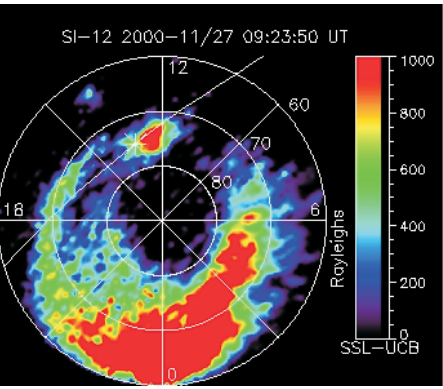
Fig. 9. IMAGE Lyman- α spectrograph data at 09:23:50 UT plotted in magnetic latitude and magnetic local time coordinates. The F12 footprint is drawn with a thin line and its position at this time is marked with an asterisk.